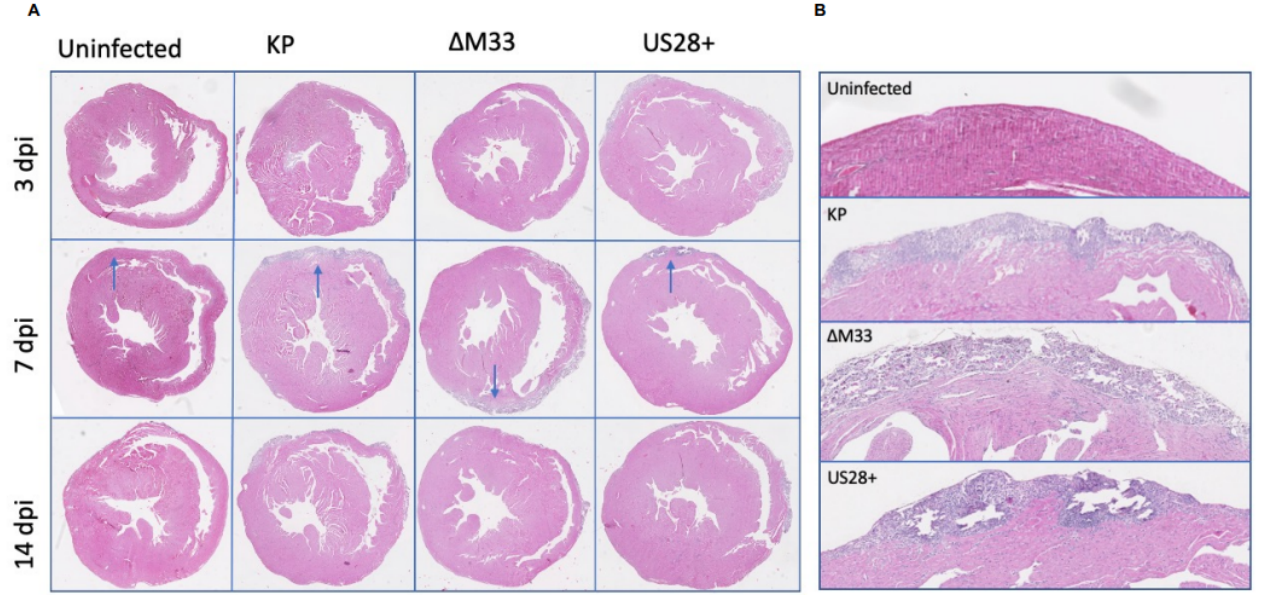
Figure 2. MCMV-induced immune cell infiltration during acute infection. Animals were uninfected or infected with 1 × 10 6 PFU by i.p. inoculation. ( A ) At 3, 7, and 14 dpi, hearts were stained with hematoxylin and eosin to evaluate immune cell infiltration during acute infection. ( B ) Enlarged view of 7 dpi calcified zones (arrows). Images presented are a representative from each group. Study was conducted in duplicate ( n = 2).